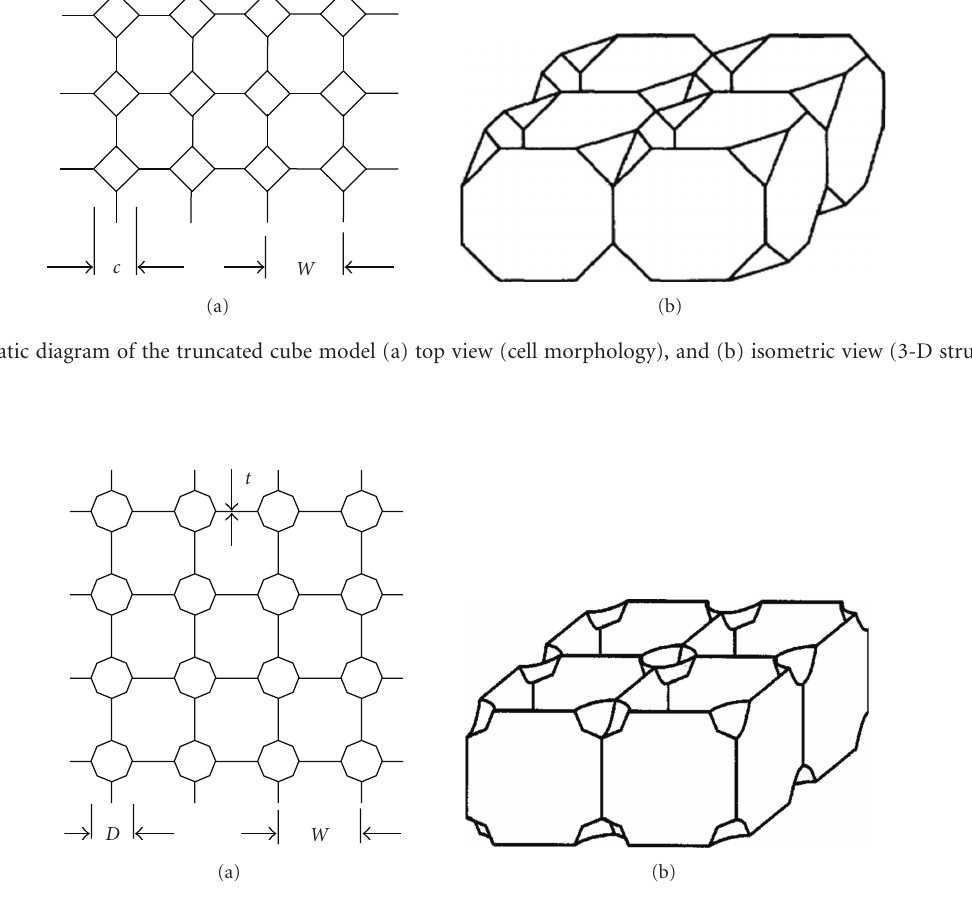
Figure 4: Schematic diagram of the cruciform-hemisphere model (a) top view (cell morphology), and (b) isometric view (3-D structure) of the model.